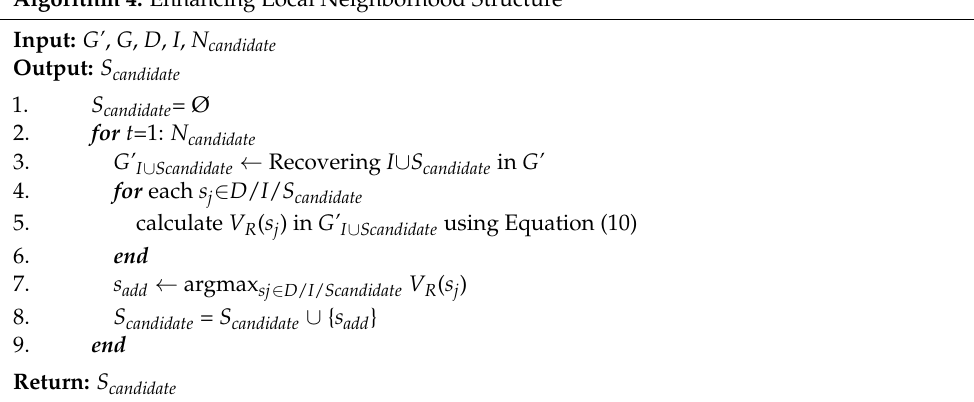
Algorithm 4. Enhancing Local Neighborhood